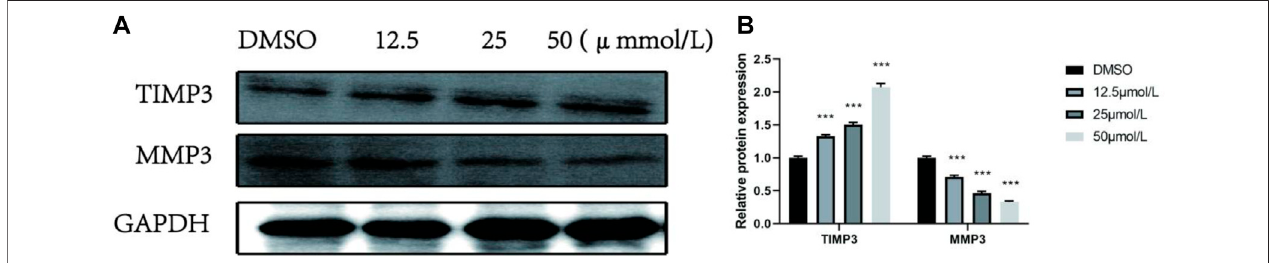
FIGURE4| EffectofRPDPRHontheexpressionlevelsofTIMP3andMMP3proteins. (A) ProteinexpressionbandsofTIMP3andMMP3proteinsinHeLacells. (B) Relative protein pro fi les of TIMP3 and MMP3 proteins in HeLa cells. Compared with the DMSO control group, * p < 0.05 and ** p < 0.01 (x ± s, n =